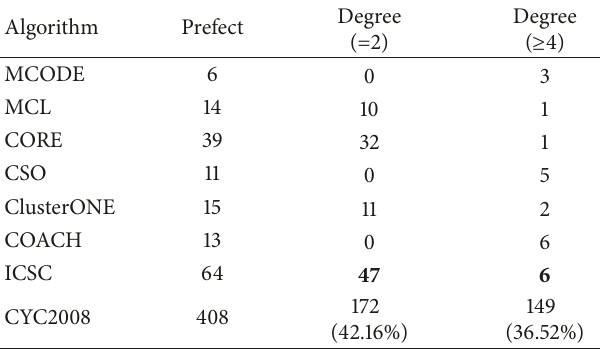
Table 3: The degree distribution of predicted protein complexes perfectly matched (OS = 1 ) on DIP